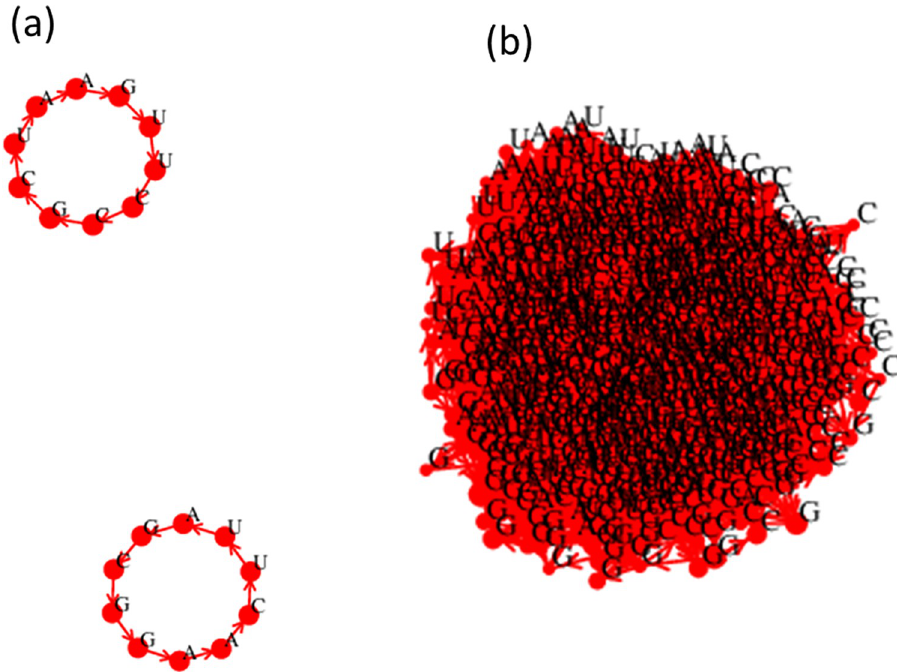
Fig 8. (a) Word graph from the perfect virtual circle of length 10. (b) Word graph of the diverse mixture arising in simulation